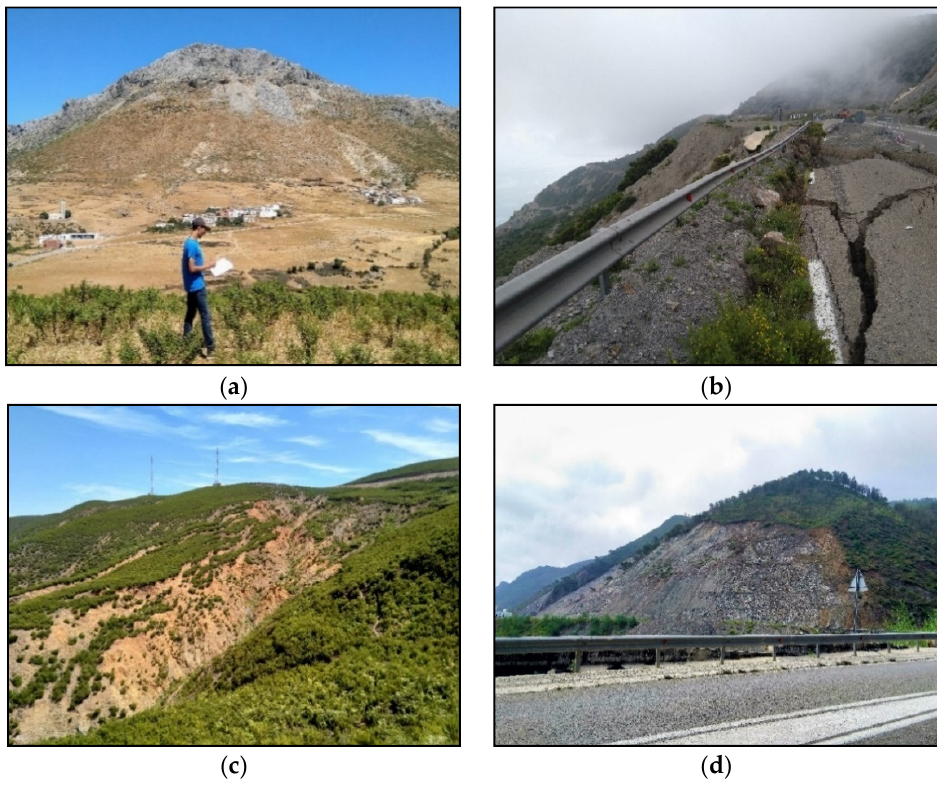
Figure 4. Examples of ground instability types in the study area. ( a ) Rockfall in a limestone cliff. ( b ) Road slope collapse. ( c ) Gullies formation in a valley slope. ( d ) Landslide in peridotites.